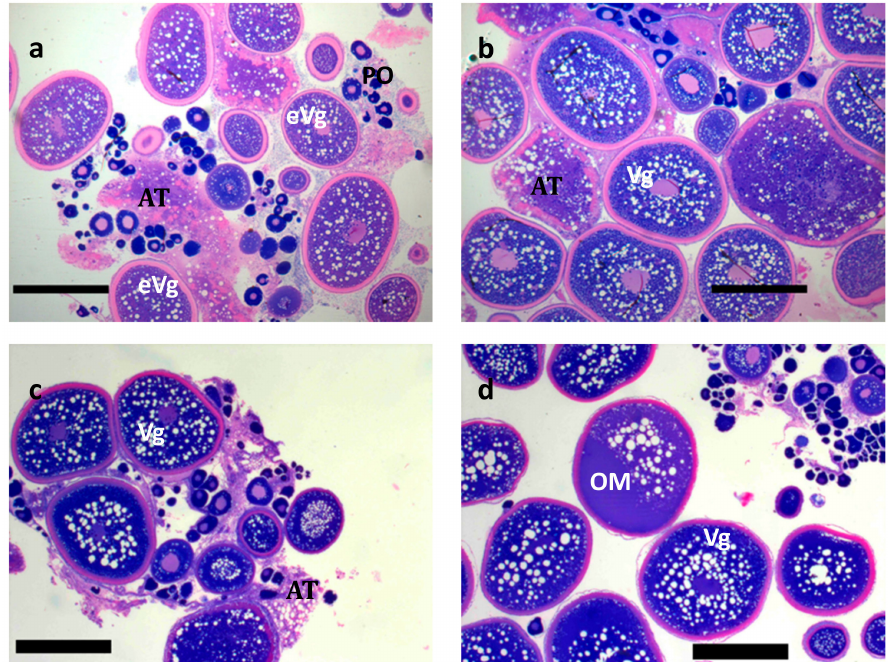
Figure 2. Ovarian biopsies from F1 greater amberjack maintained in land-based tanks in Tenerife, Canary Islands and processed for histology ( a ): Female in May in early Vitellogenesis (eVg) with a large number of primary oocytes (PO) as well as atresia (AT). ( b ): Female in May with oocytes in full Vg. ( c ): Female in mid-July, in full Vg. ( d ): Female in mid-September, having oocytes in oocyte maturation (OM) and Vg. Bar = 500 µ m.